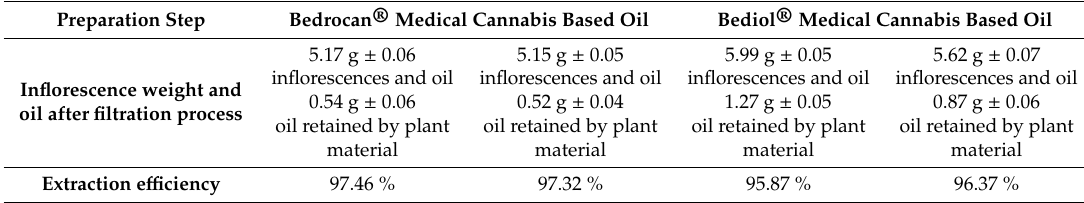
Bedrocan ® Medical Cannabis Based Oil Bediol ® Medical Cannabis Based Oil